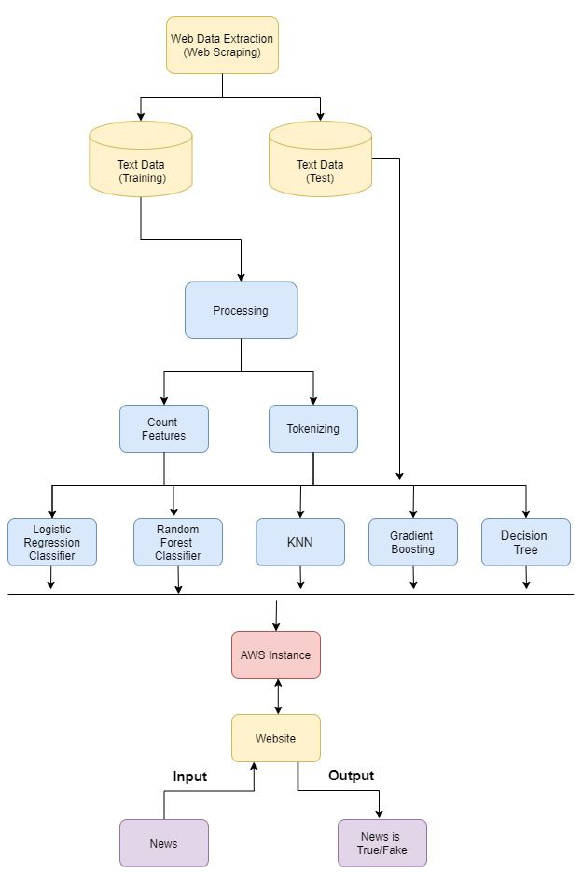
Figure 1: Workflow